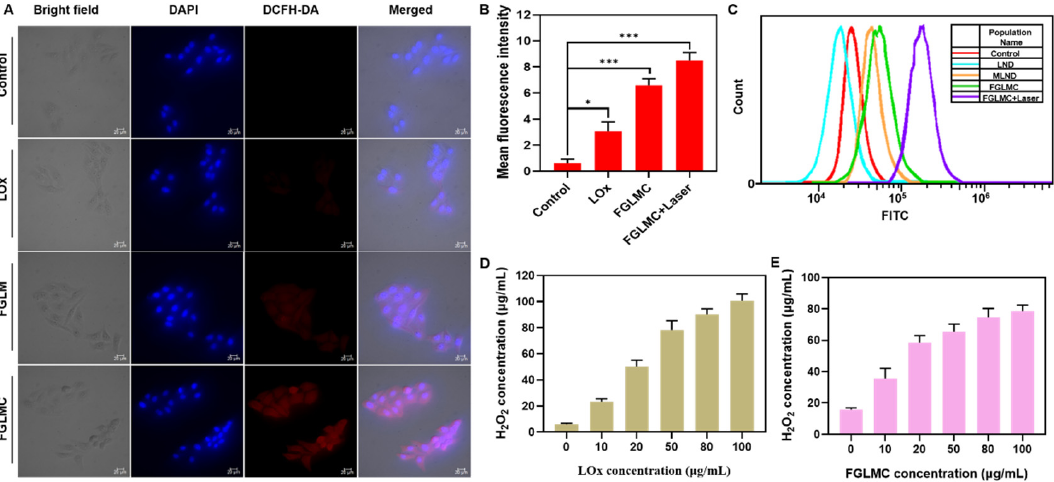
Figure 3. The detection mechanism of DCFH-DA for intracellular ROS. Confocal fluorescence images ( A ), the quantification of fluorescence intensity ( B ), and flow cytometry assay ( C ) for the generation of ROS with different treatments (Scale bars represent 20 µ m, * p < 0.05 *** p < 0.0005). Detection of H 2 O 2 incubated with different concentrations of ( D ) LOx and ( E ) FGLMC in MCF-7 cells. Each value represents means ± SD ( n = 3).